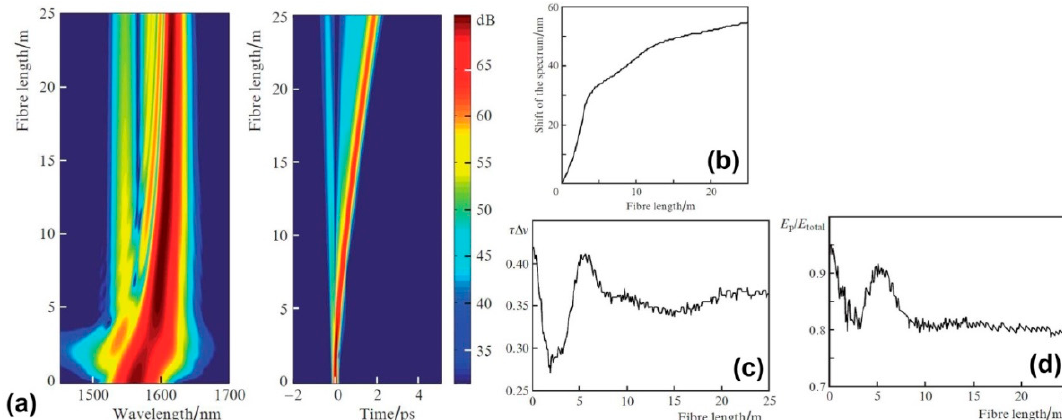
Figure 17. Propagation of a 100-fs transform-limited Gaussian pulse with an input power of 10 MW through the RF: ( a ) color density plot of pulse evolution; ( b ) red-shift of the pulse spectrum; and, ( c , d ) time-bandwidth product and pulse energy as functions of fiber length [79].